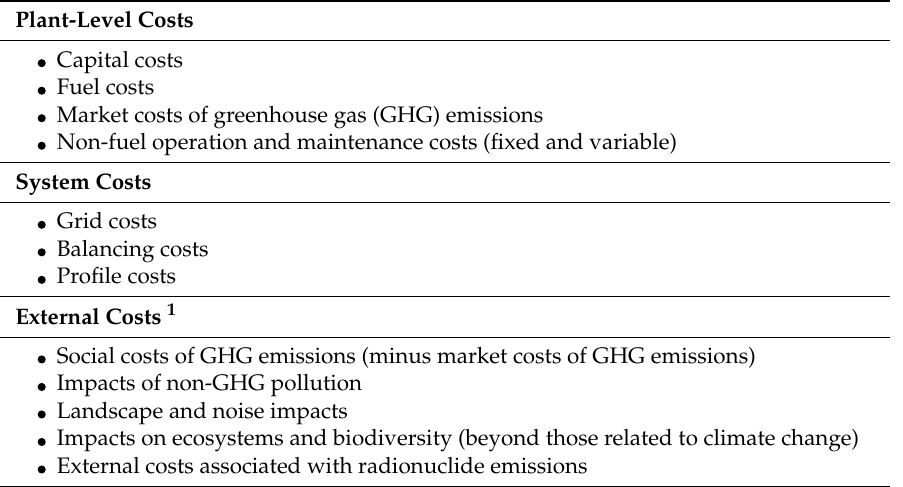
Table 1. Overview of the sub-categories of costs found to be relevant for comparing the social costs of electricity generation